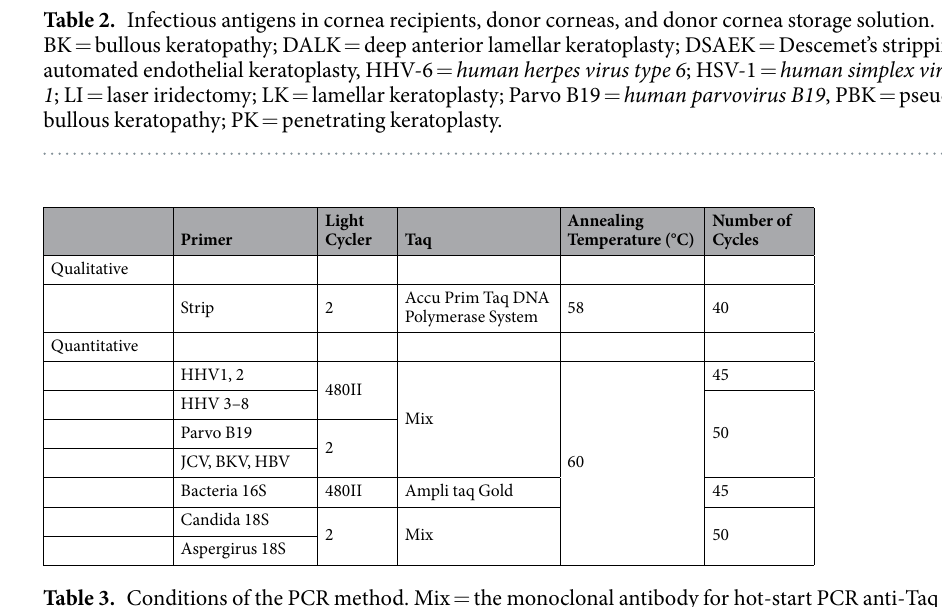
Table 3. Conditions of the PCR method. Mix = the monoclonal antibody for hot-start PCR anti-Taq high